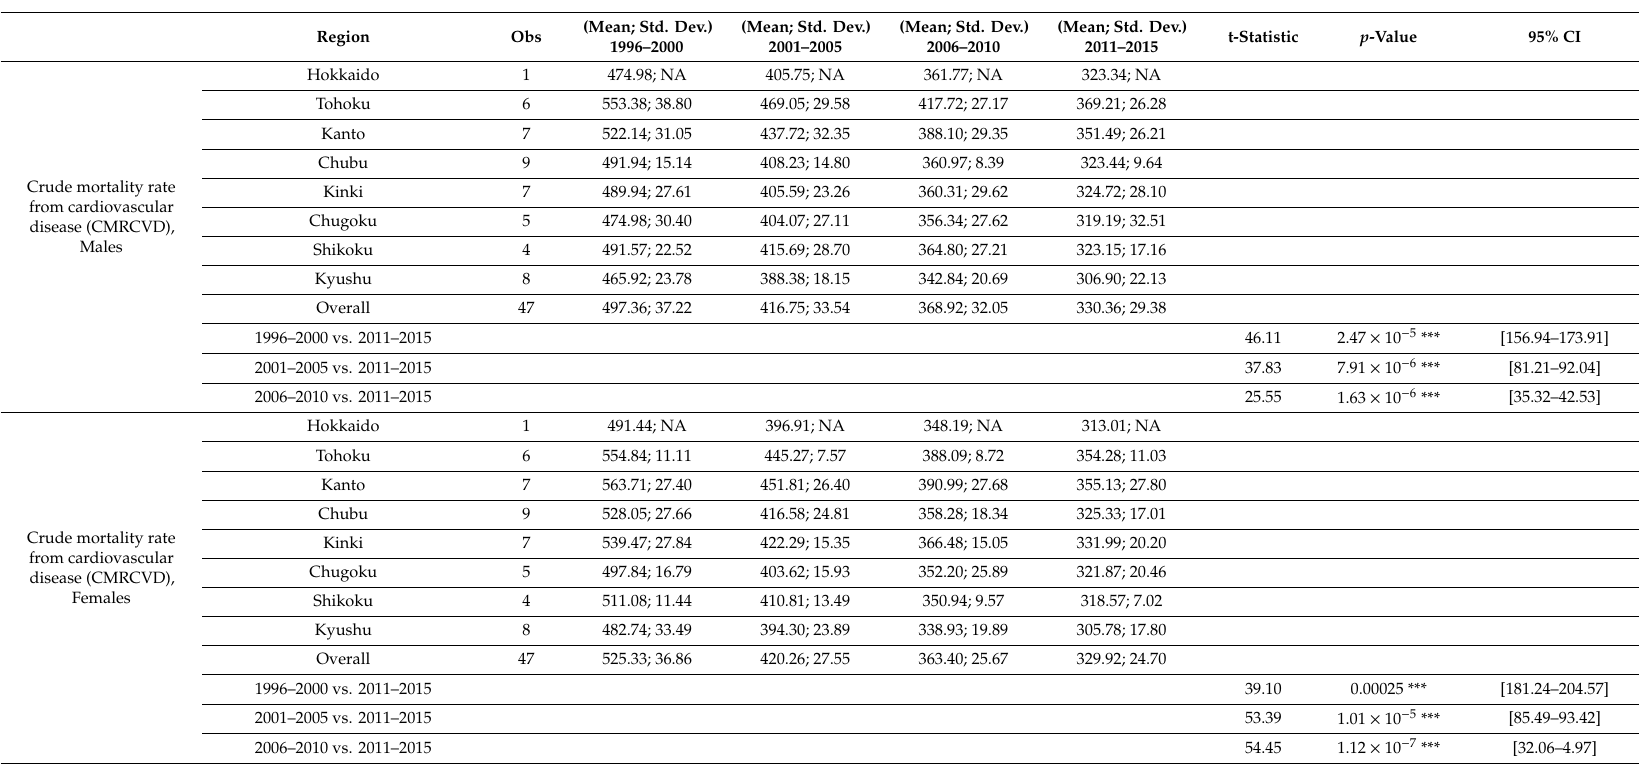
Table 1. Descriptive statistics—cardiovascular disease (CVD) mortality rates and gross domestic product (GDP) per capita, by sex and period.